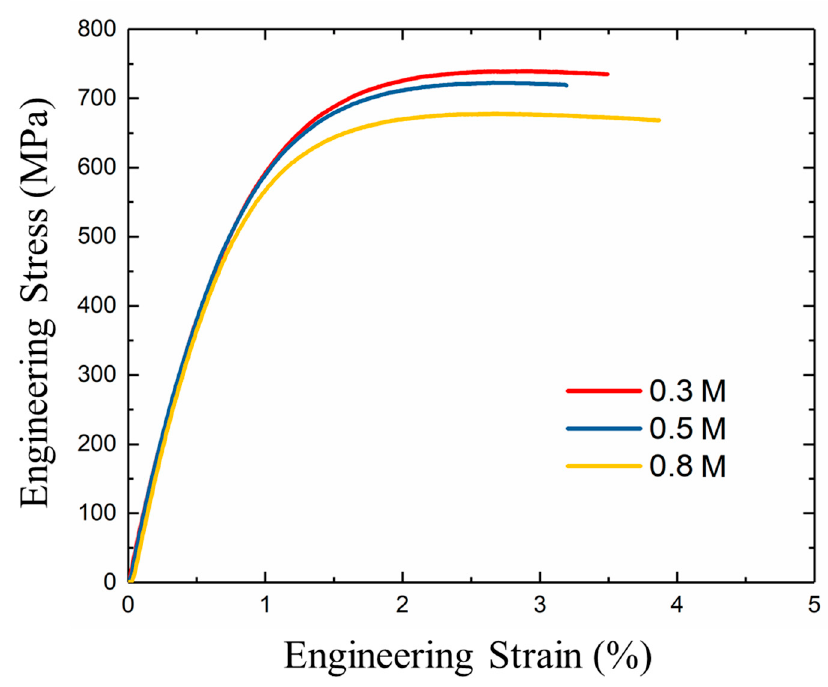
Figure 10. Stress-strain characteristics of the 15- µ m thick nt-Cu foils electroplated with different concentrations of Cu 2+ . Table 2. Summary of the mechanical properties of the 15- μ m thick nt-Cu foils electroplated with different concentrations of Cu 2+ . The calculated yield stress (YS) was obtained using the classical Hall-Petch equation (Equation (1)).